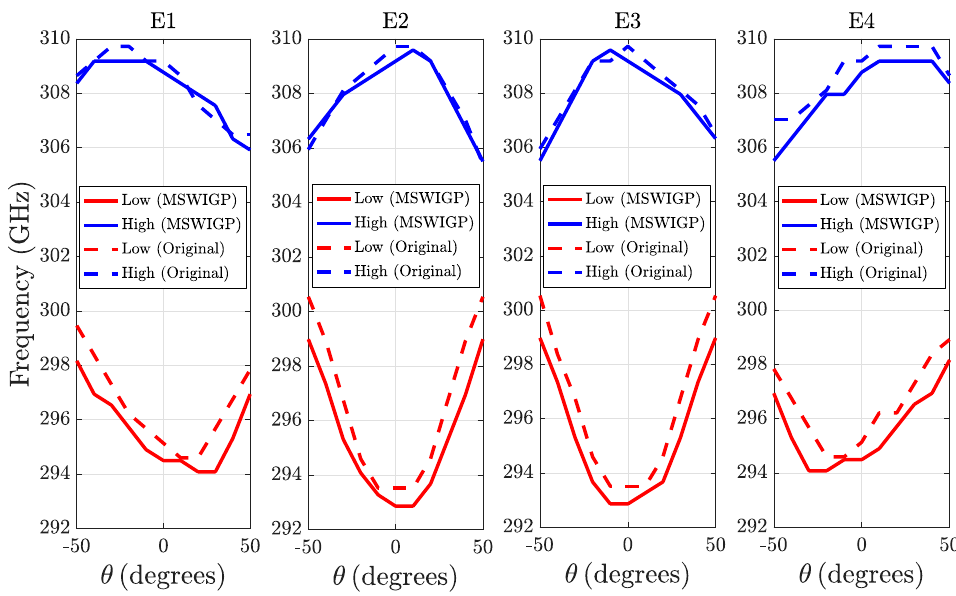
Figure 9. Comparison of reflection coefficient between MSWIGP and the original design.